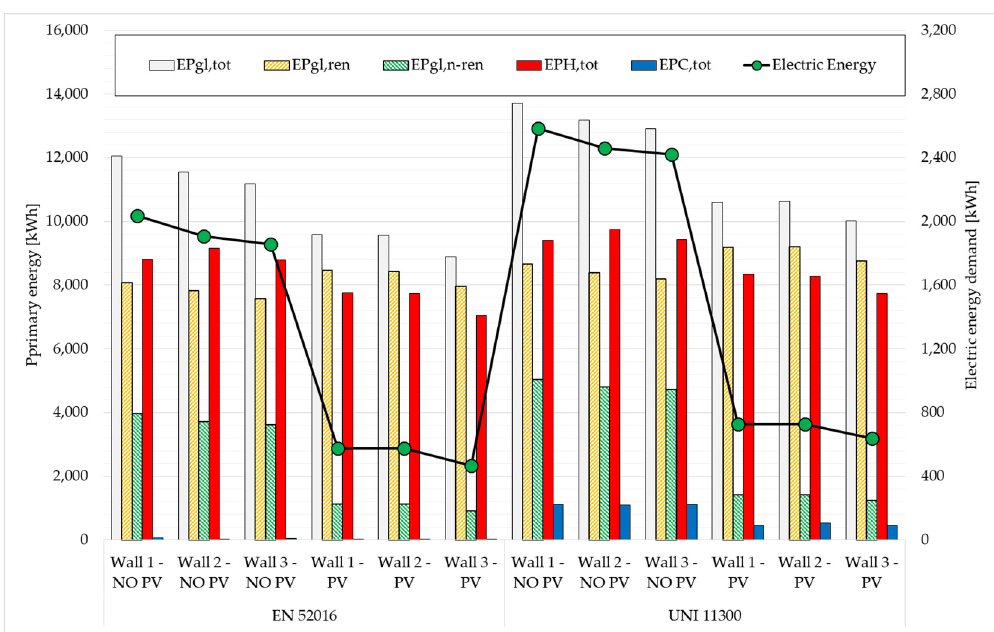
Figure 10. Primary energy need contribution (EP gl,tot , EP gl,n-ren , EP gl,ren ), primary energy needs for heating (EP H,tot ) and for cooling (EP H,tot ) and the electric energy need for the chosen case study. Table 10. Total electric consumption over a year for the three studied walls.